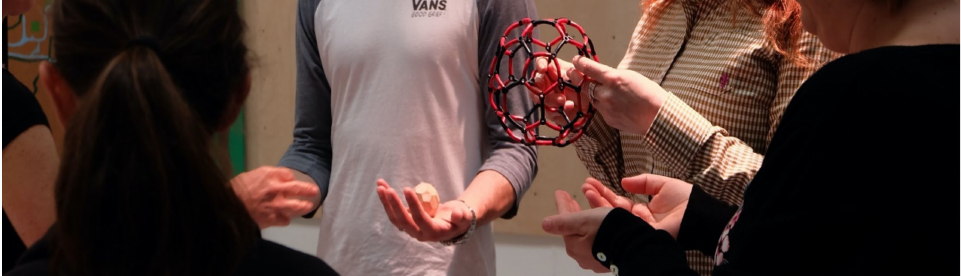
Figure 3. TFS workshops, task 1—Knowle West Media Centre, 2018.